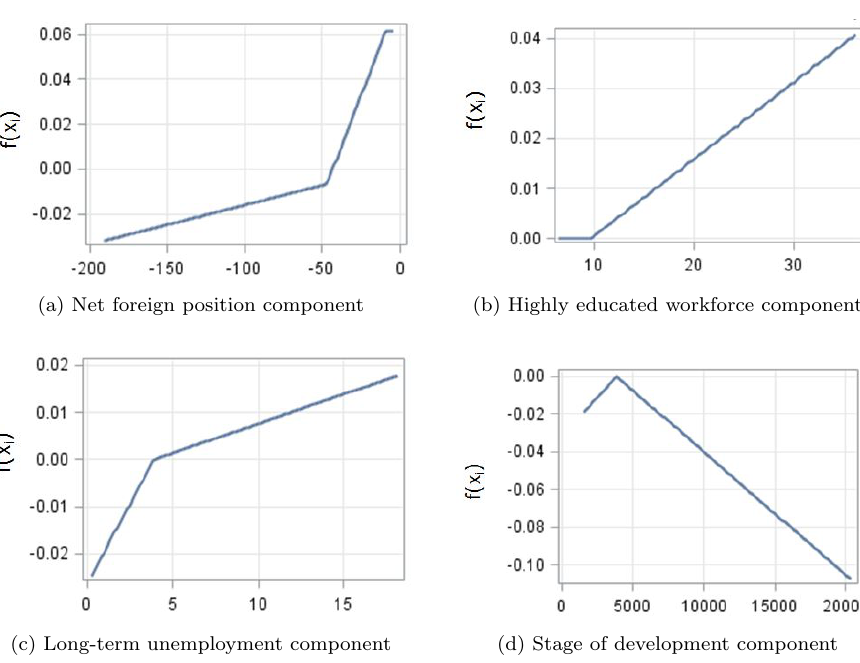
Figure 2: MARS EU13 additive model: dependence of growth on the main four factors, as detected by the model.